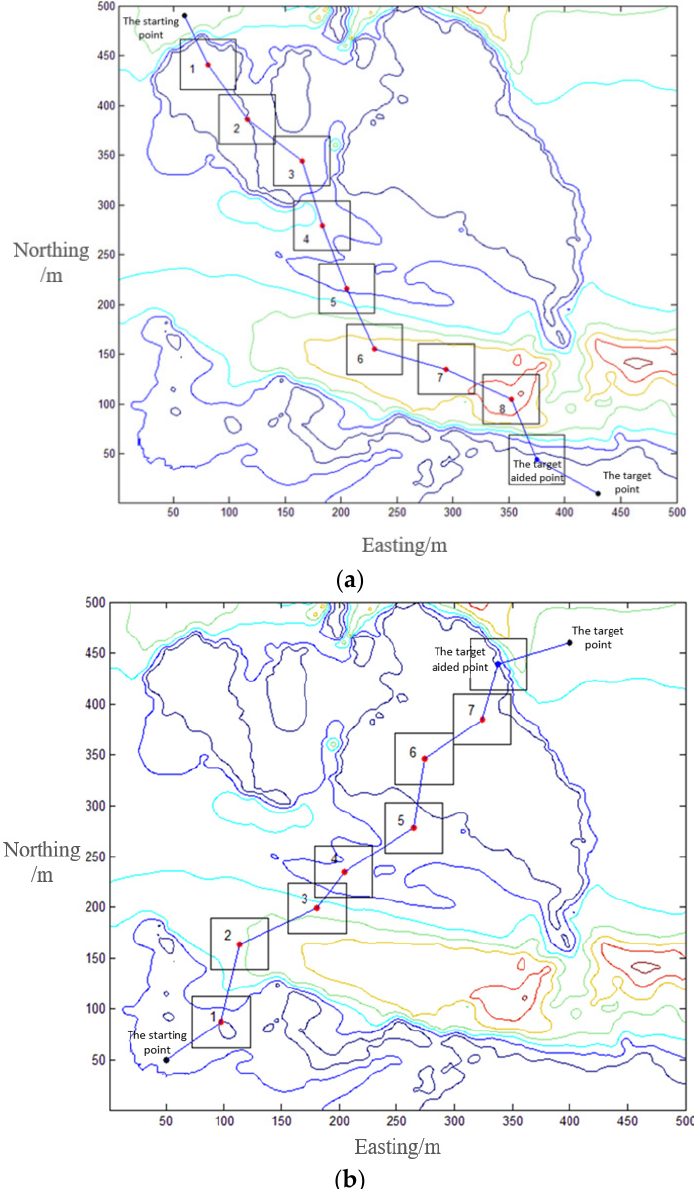
Figure 15. The generated path in case study 3. ( a ) The path according to the points demonstrated in the Table 7; ( b ) The path according to the points demonstrated in the Table 8.